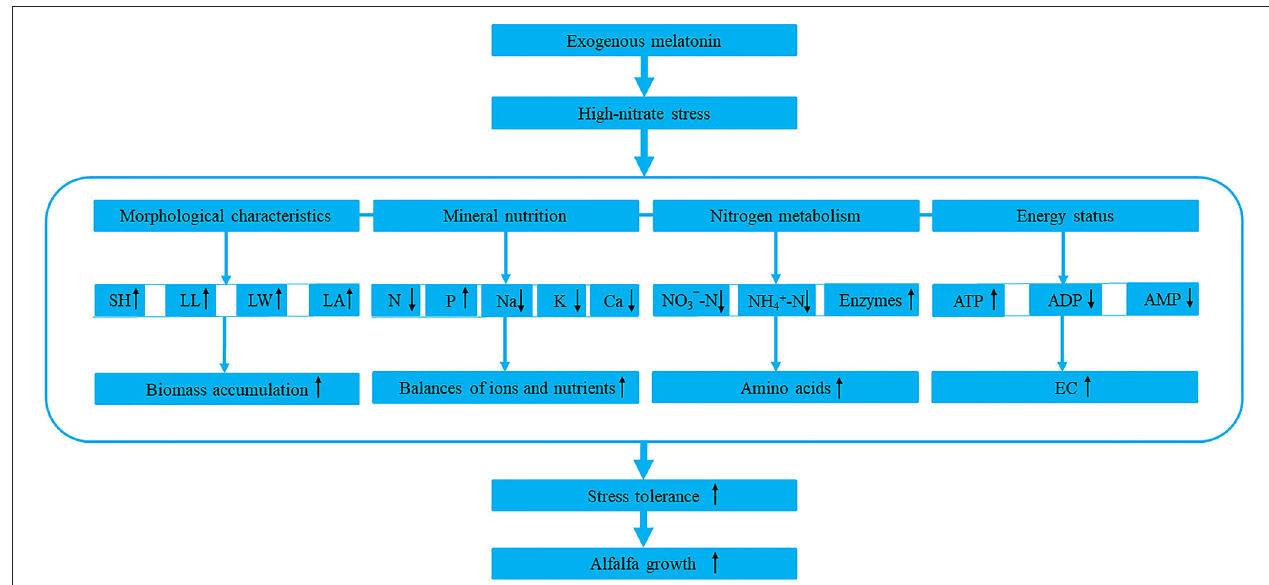
FIGURE 8 | The model of melatonin response to high-nitrate stress in alfalfa. SH, LL, LW, and LA represent shoot height, leaf length, leaf width, and leaf area, respectively. N, P, Na, K, and Ca represent nitrogen, phosphorus, sodium, potassium, and calcium, respectively. NO − 3 -N and NH + 4 -N represent nitrate-nitrogen and ammonium-nitrogen, respectively. Enzymes include NR (nitrate reductase), GS (glutamine synthetase), GOGAT (glutamate synthase), and GDH (glutamate dehydrogenase). ATP, ADP, AMP, and EC represent adenosine triphosphate, adenosine diphosphate, adenosine monophosphate, and energy charge. The upward or downward black arrows represent promotion or inhibition, respectively. The blue dash indicates that the four components are closely related to each other.